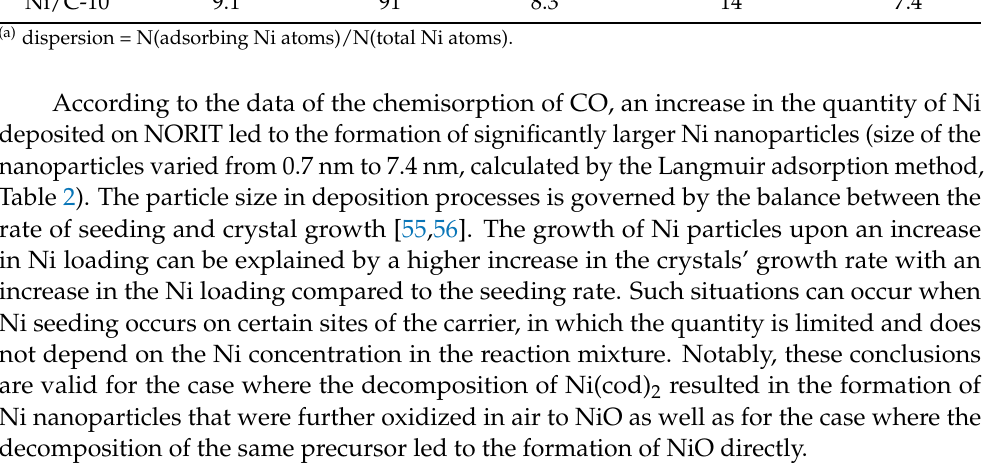
Table 2. The results of the analysis of the composites by CO chemisorption using the Langmuir model. S Ni , m 2 /g S Ni , m 2 /g Composite Ni Content, % Dispersion (a) , % d Ni , nm (Ni) (Composite) Ni/C-1 0.9 935 8.4 100 0.7 Ni/C-3